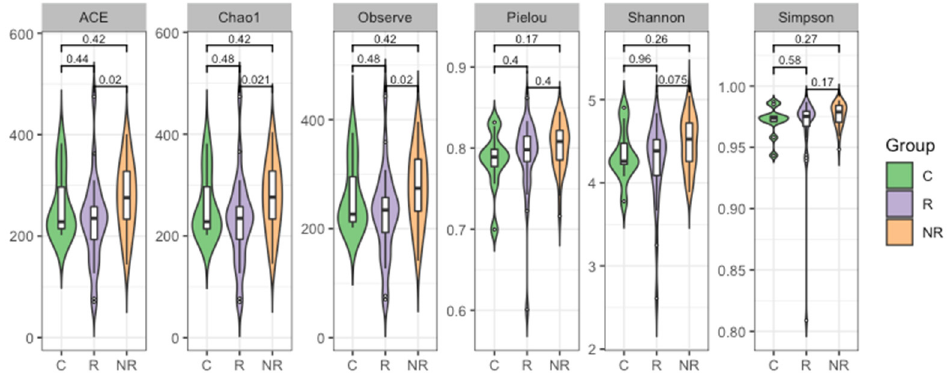
estimated regarding richness (ACE, Chao1, and observed indices), evenness (Pielou index), and di- versity (Shannon and Simpson indices) measures in study groups (R—responders, NR—non-re- sponders, and C—controls). Wilcoxon Rank Sum Test indicated that the responder and non-re- sponder groups’ microbiota differed in regards to richness ( p <